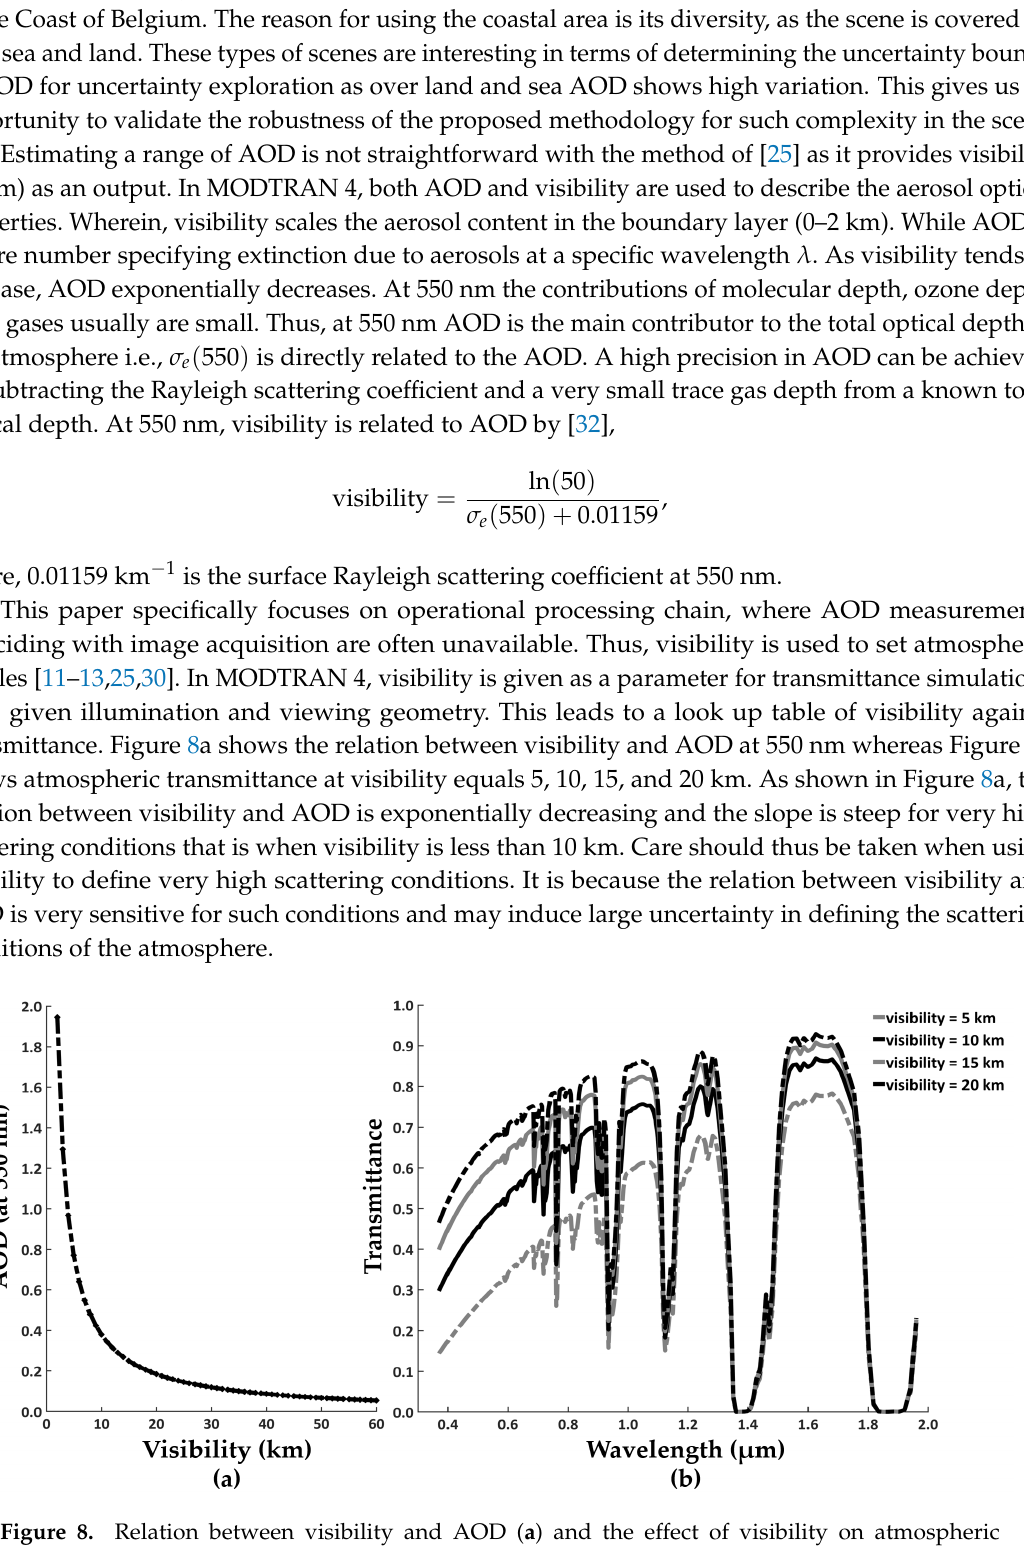
Figure 8. Relation between visibility and AOD ( a ) and the effect of visibility on atmospheric transmittance ( b ). The standard MODTRAN 4 Mid-Latitude Summer model with correlated k-option is used with column water vapor = 2.0 g cm − 2 and the other atmospheric parameters are at their default